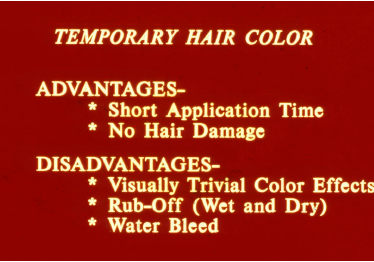
Figure12. Rudimental elements of temporary hair color.